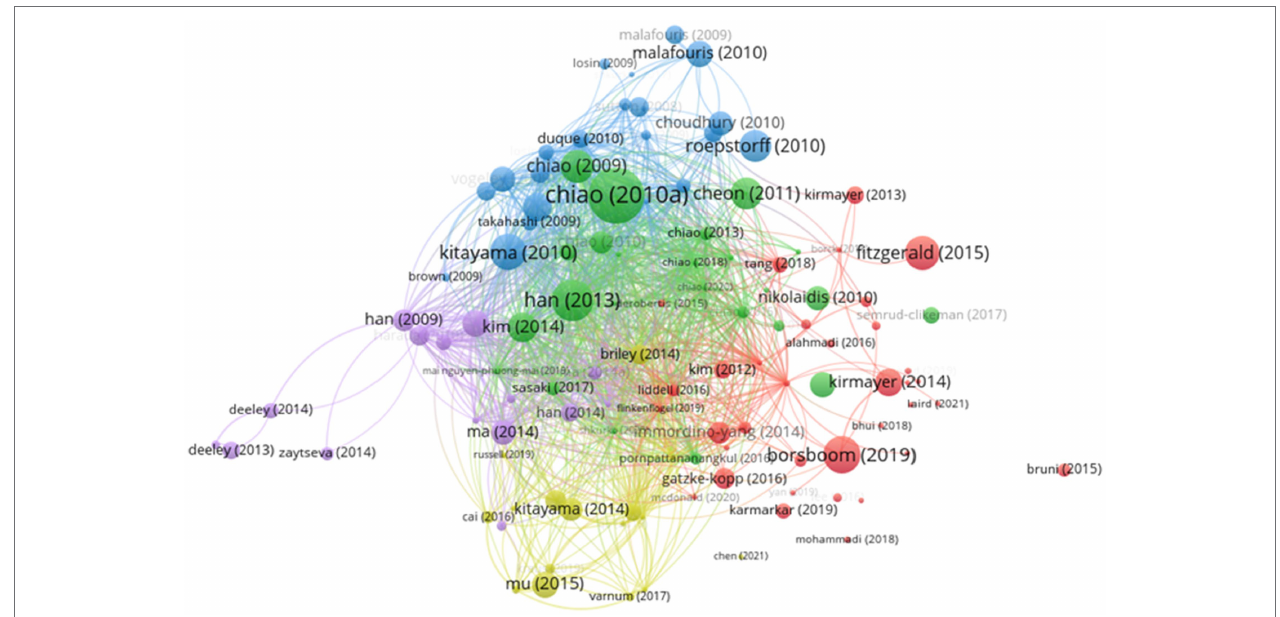
FIGURE 6 | Bibliographic coupling